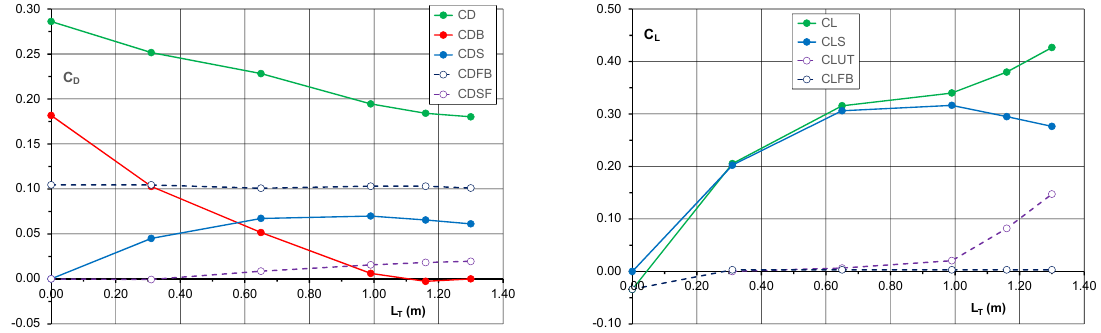
Figure 10. Breakdown of drag, ( left ), and lift, ( right ), coefficients for 2D taper case. For the breakdown of lift, the slant surface lift coefficient, C LS , shown in blue, follows the overall lift coefficient trend closely up to a tail length of 1.0 m, after which it reduces slightly while the overall lift increases. The difference between the slant surface and the overall lift coefficient for tail lengths longer than 0.31 m represents the incremental lift coefficient on the underside of the tail, C LUT , and is shown in purple. This also assumes that the forebody lift coefficient, C LFB , shown in dark blue, is constant, for these tails, where the forebody includes all upper surfaces forward of the leading edge of the slant surface and the underbody surface back to the trailing edge of the underfloor of the squareback (and initial slant surface) body. The squareback body includes the additional upper sur- face aft of the slant leading edge position. The increase in tail underfloor lift coefficient with the longest tails arises from the positive pressure in this region and the build-up of the boundary layer on the underside of the tail and ground surfaces.